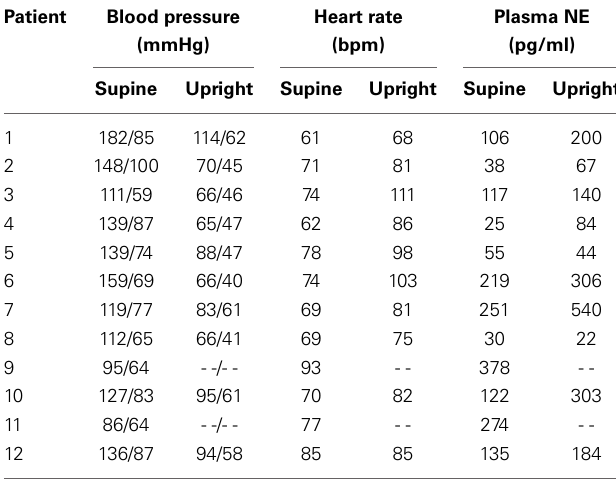
Table 2 | Orthostatic stress